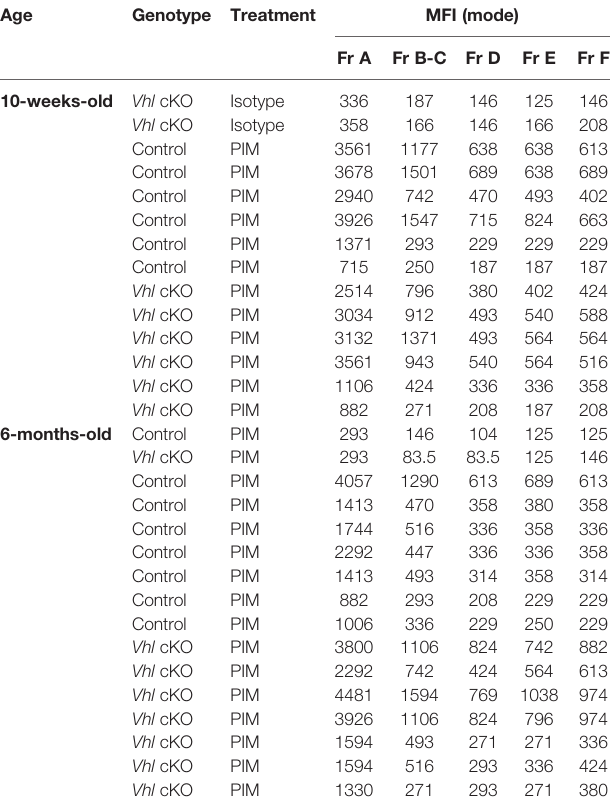
TABLE 2 | Mode Fluorescence Intensity of PIM staining on B cell fractions in control and Vhl cKO mice. Age Genotype Treatment MFI